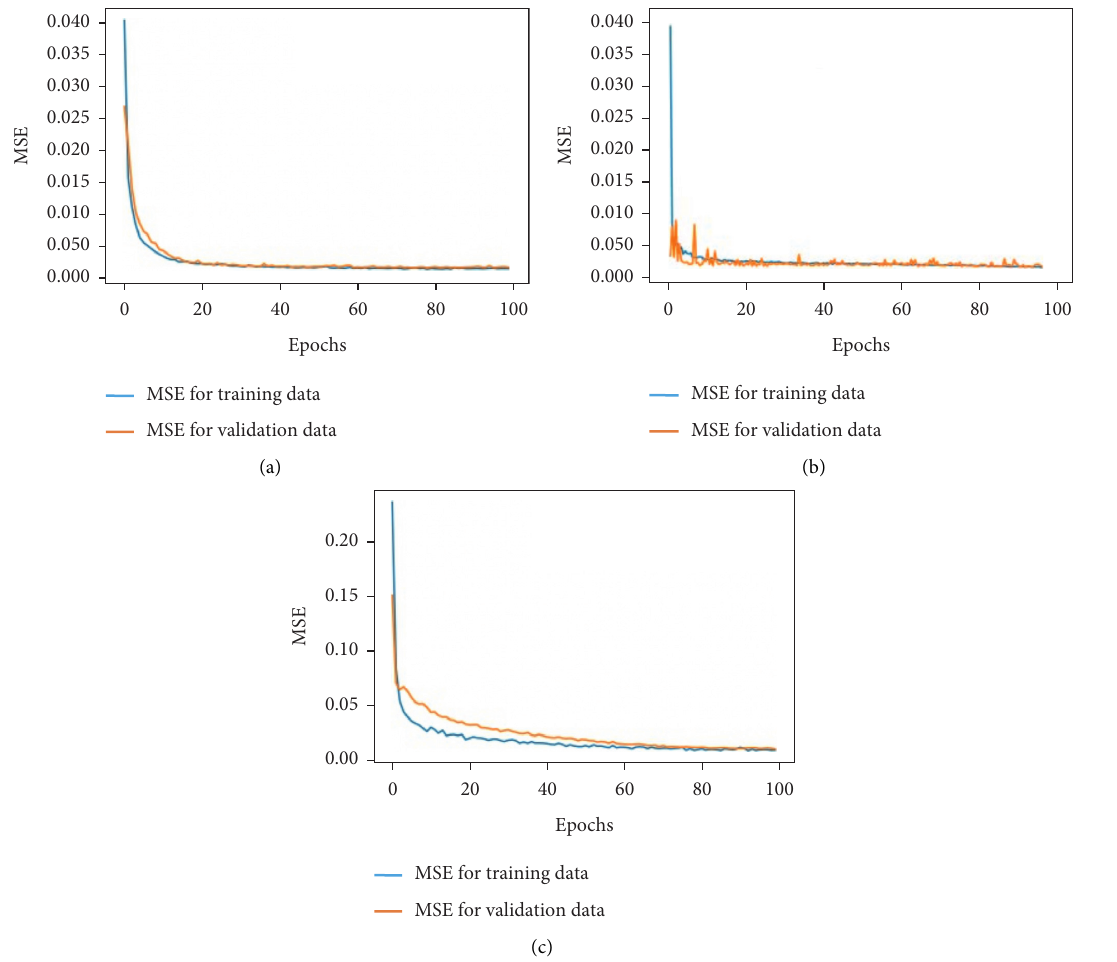
Figure 8: MSE for validation and training data for (a) daily, (b) weekly, (c) monthly forecasting